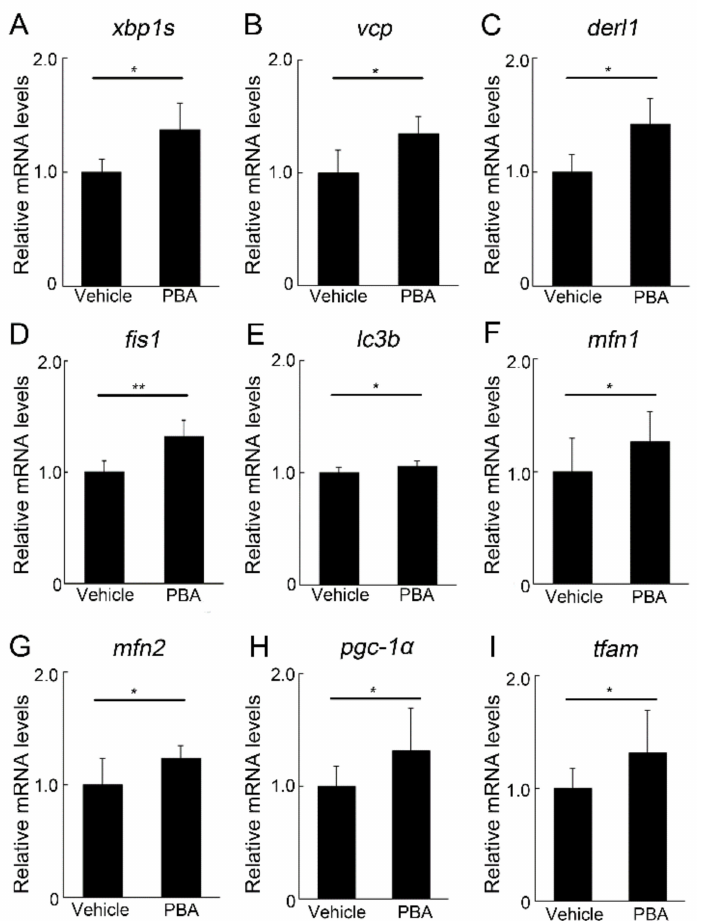
Figure 4. Induction of ERAD and mitochondrial marker mRNAs by PBA in the retina of P23H RP models ( A – I ) Real-time RT-PCR of the retinal samples obtained at the age of 4 weeks with or without PBA treatment. ERAD-related ( A – C ), mitochondrial kinetic ( D , F , G ) and autophagy ( E ) markers, pgc-1 α ( H ), and tfam ( I ) were upregulated by PBA treatment. ERAD, ER-associated degradation. Data are shown as mean ± standard deviation. n for P23H RP models treated with vehicle and PBA, ( A – C ) 4–5; ( D – I ) 7–10. * p < 0.05, ** p <